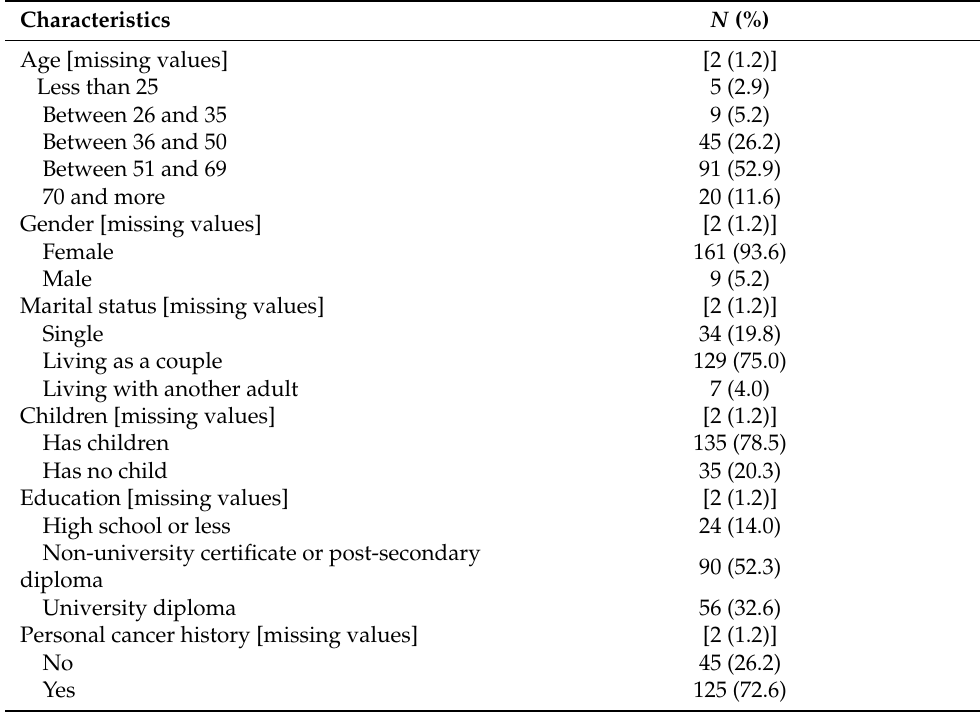
Table 1. Characteristics of validation sample ( N = 172).